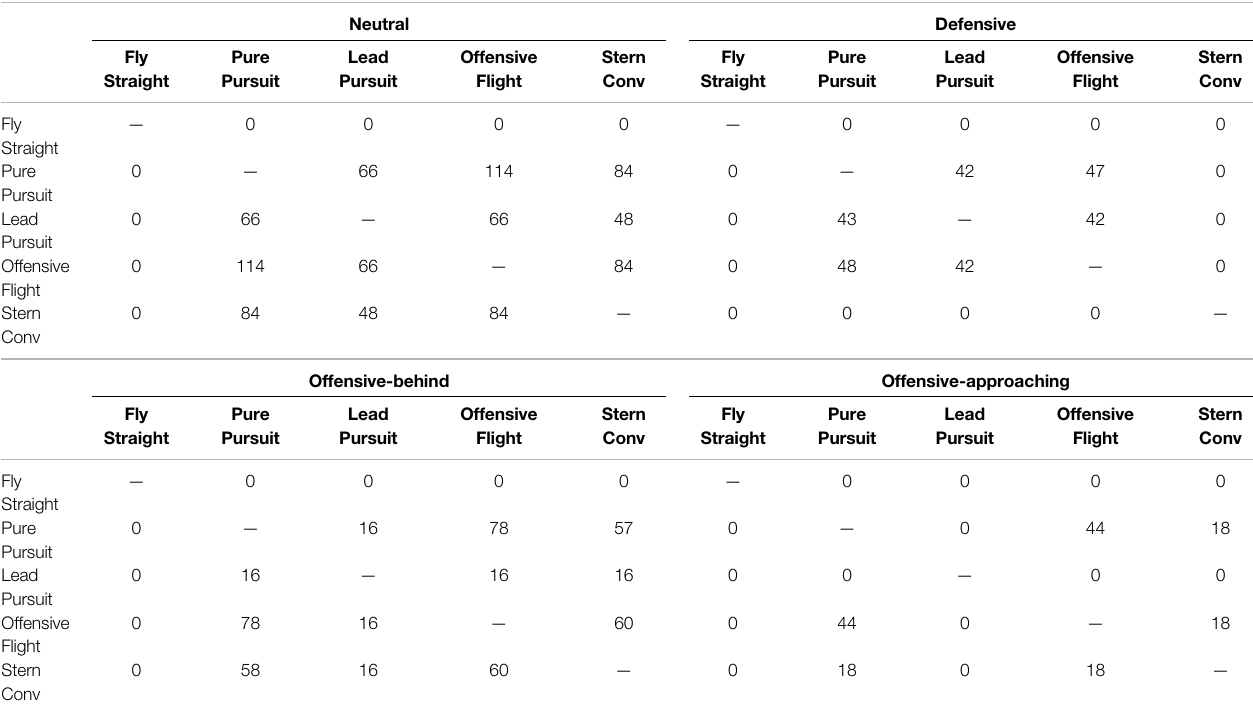
TABLE 3| Thenumberoftiesforeach behaviourwithrespecttothedifferentinitial con fi gurations, correspondingtothefour quadrants oftheangularsituation classi fi